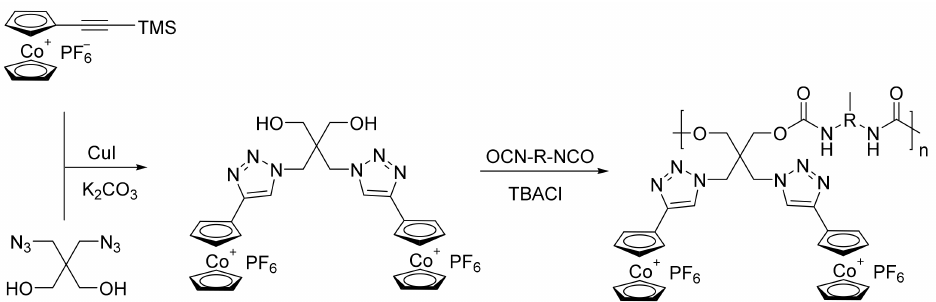
Figure 15. Synthetic procedure for cobaltocenium-containing polyurethane-type inhibitors: P-40/P- 41/P-42/P-43